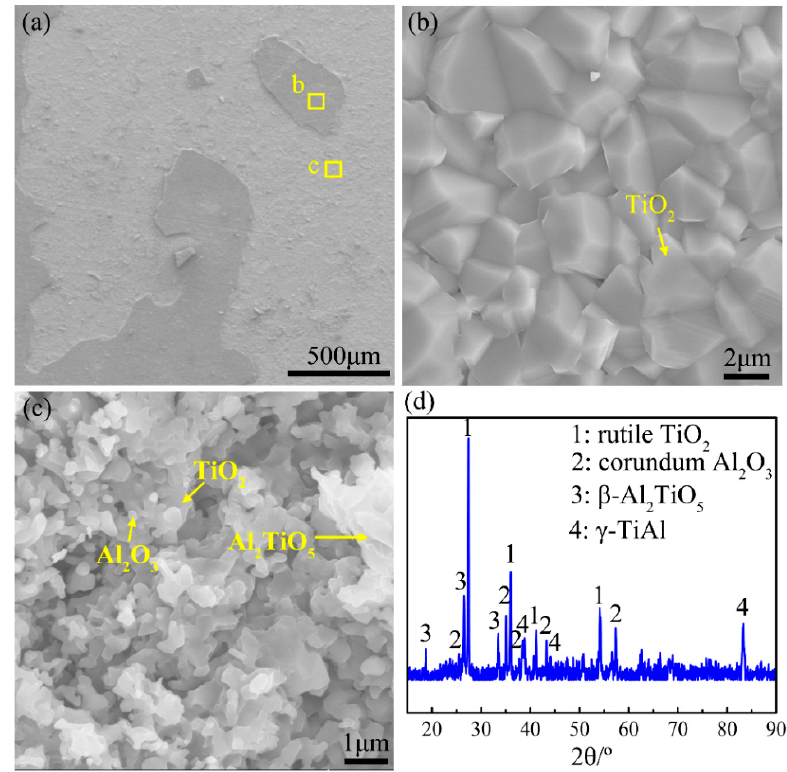
Figure 9. ( a – c ) Surface morphologies and ( d ) XRD pattern of the oxide scale formed during heating the Ti-46Al-2Cr-5Nb alloy to the end of Stage IV.